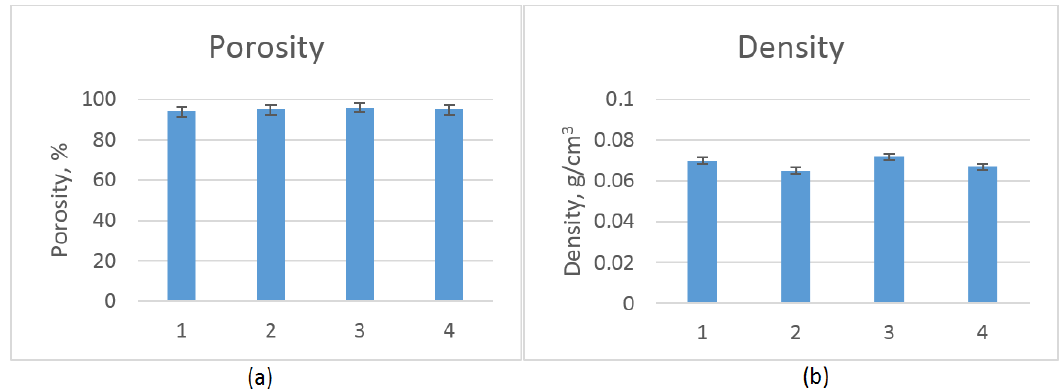
Figure 3. ( a ) Porosity of the prepared scaffolds; and ( b ) density of the prepared scaffolds .